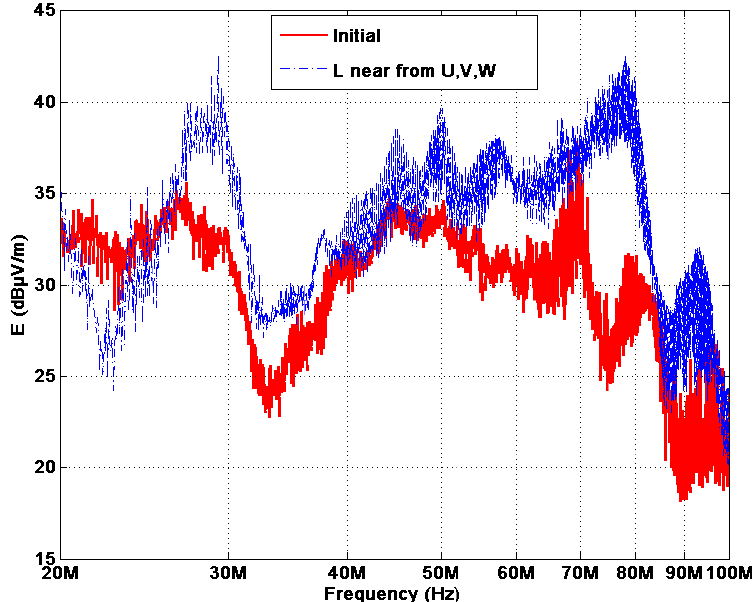
Figure 10. Far field measurement showing the influence of the